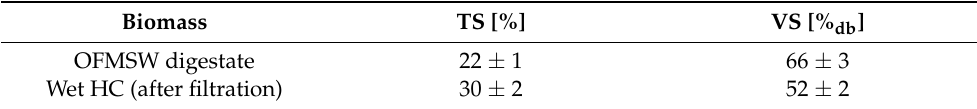
Table 1. Characterization of total solids (TS) and volatile solids (VS on dry basis % db ) of the biomass before and after Hydrothermal Carbonization (HTC) (mean and standard deviation from measures in triplicate).